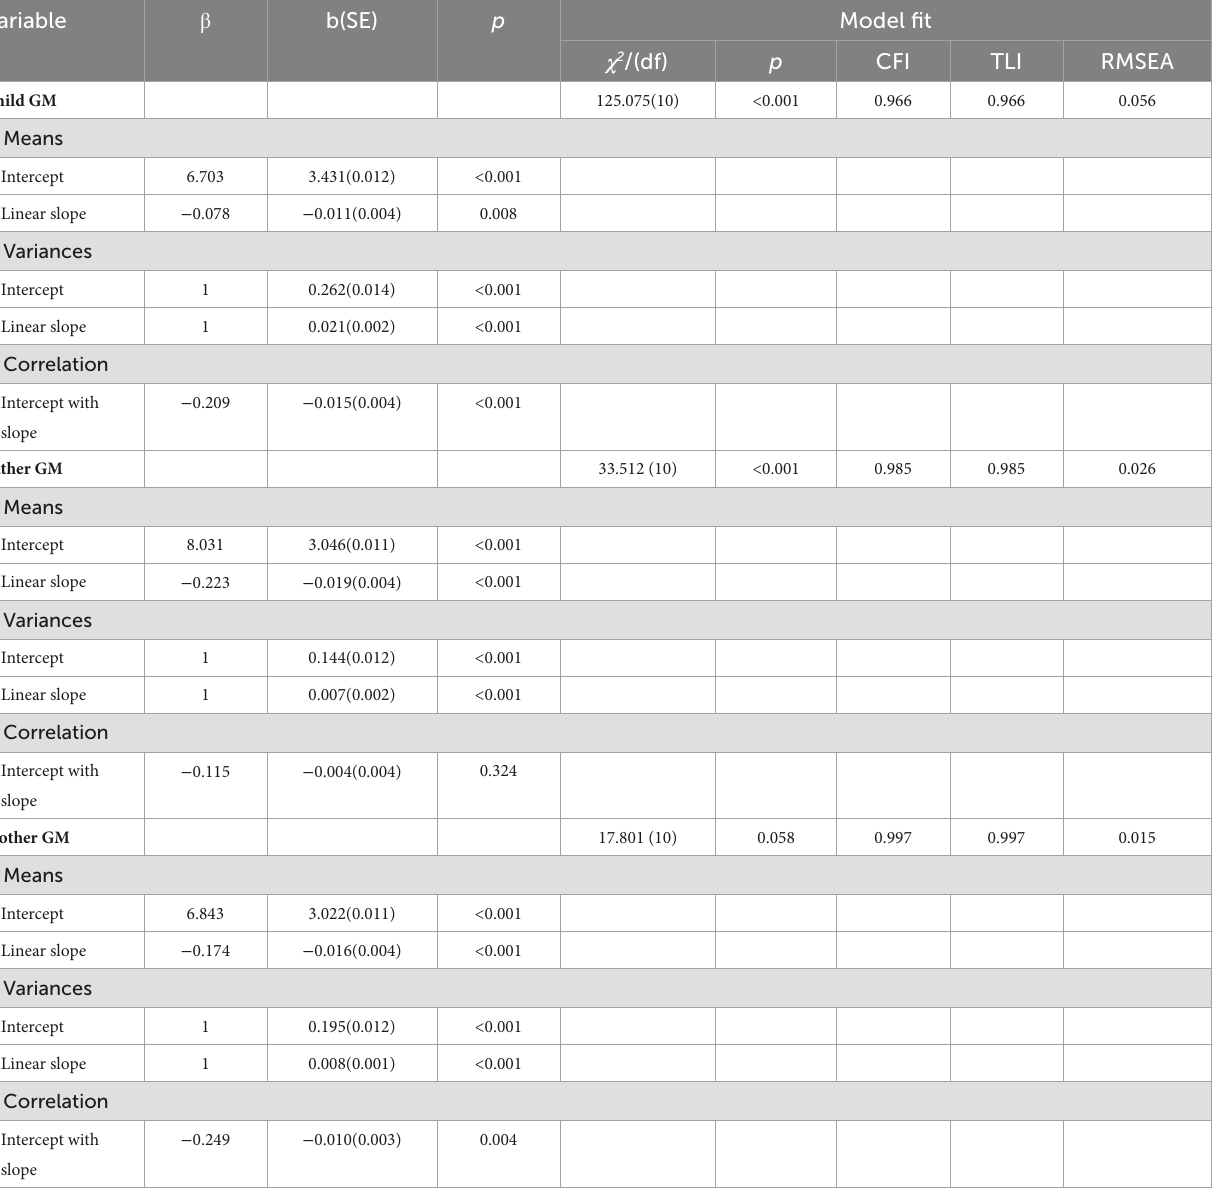
TABLE 3 Parameter estimates and model fit for univariate growth models.